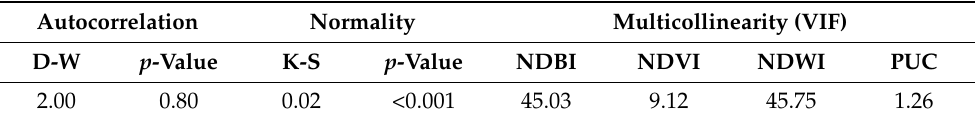
Table 4. Fulfillment of the Assumptions.